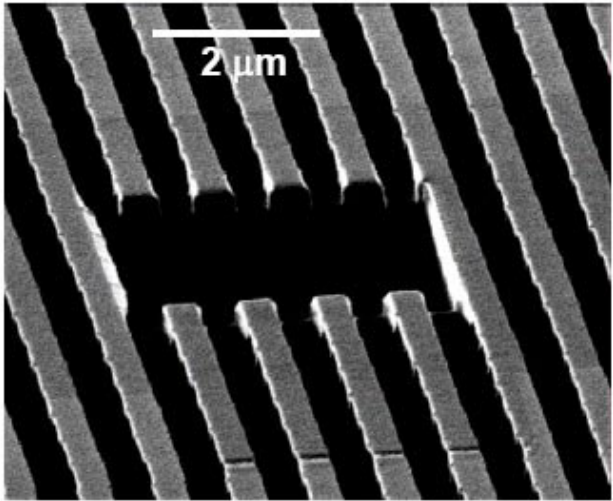
FIG. 8. Electron microscope picture of a fused silica grating with a period of 1 (cid:2) m . The hole in the center was cut to expose the surface profile of the